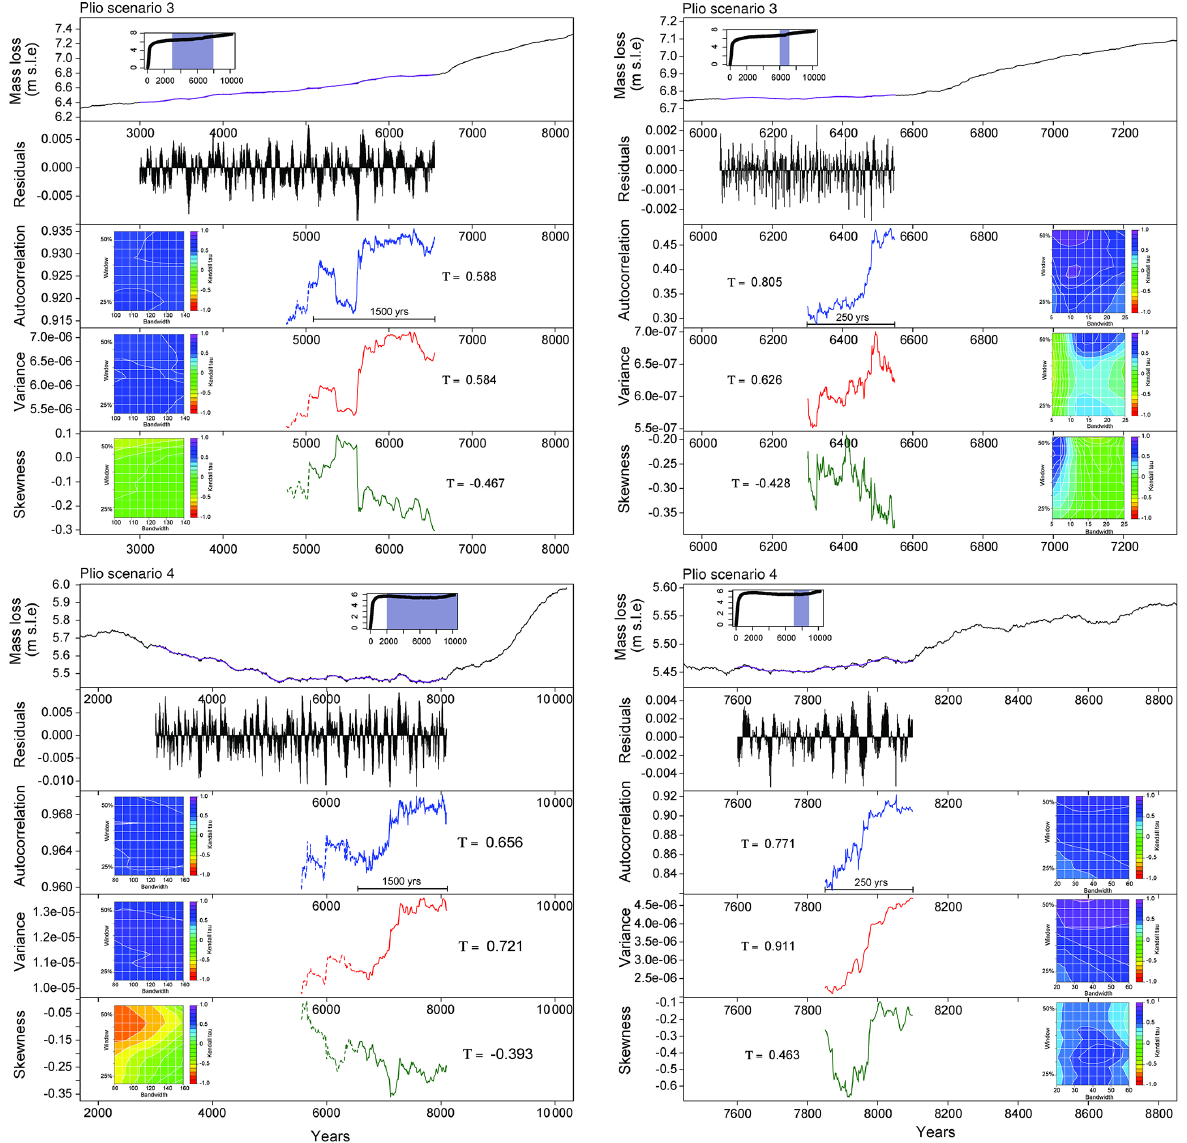
Figure 9. Tipping point analyses for two scenarios. Upper row shows results of analyses of dT + 2 ◦ C, dSST + 0 ◦ C, lower row shows dT + 0 ◦ C, dSST + 1 ◦ C. In each panel, top row shows modelled mass loss curve with inset identifying period used in the tipping point analysis. The four lower rows each show one key indicator metric (residuals, autocorrelation, variance, skewness) as described in “Methods”. Left and right columns show results based on 1500-year (from the solid line; dashed line shows analysis prior to this window) and 250-year sliding windows respectively. Note the steeper trends and higher tau values in the shorter analyses, indicative of a stronger signal over the shorter timeframe. Inset contour plots display the range of Kendall tau values for different sliding window lengths (25–50%) and smoothing bandwidths